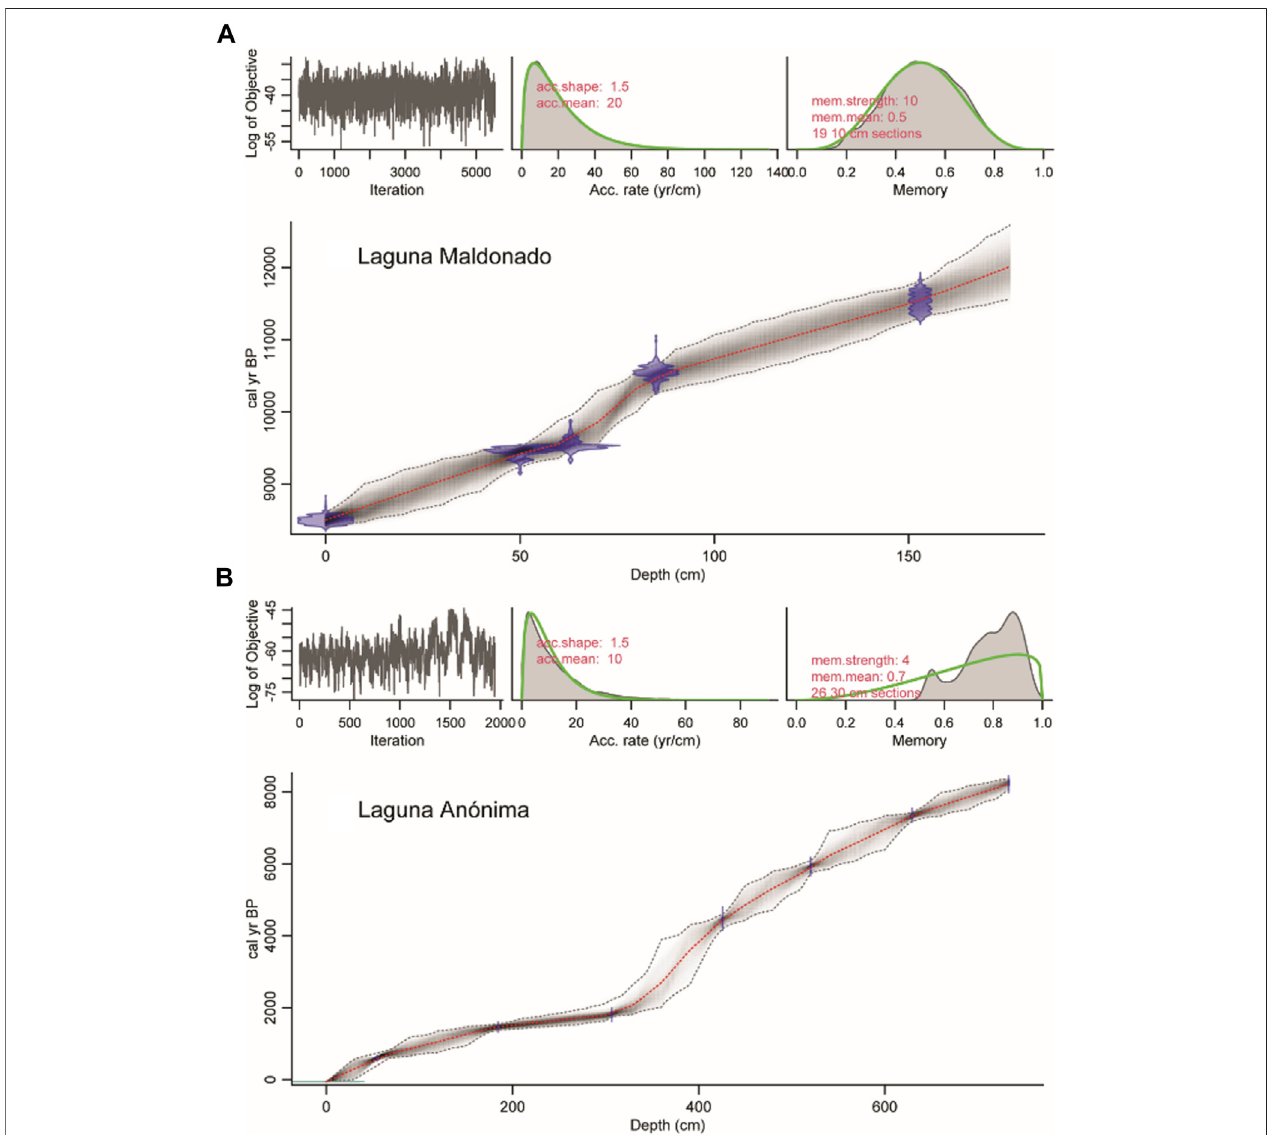
FIGURE 3 | Age – depth models of (A) Laguna Maldonado and (B) Laguna Anónima records.